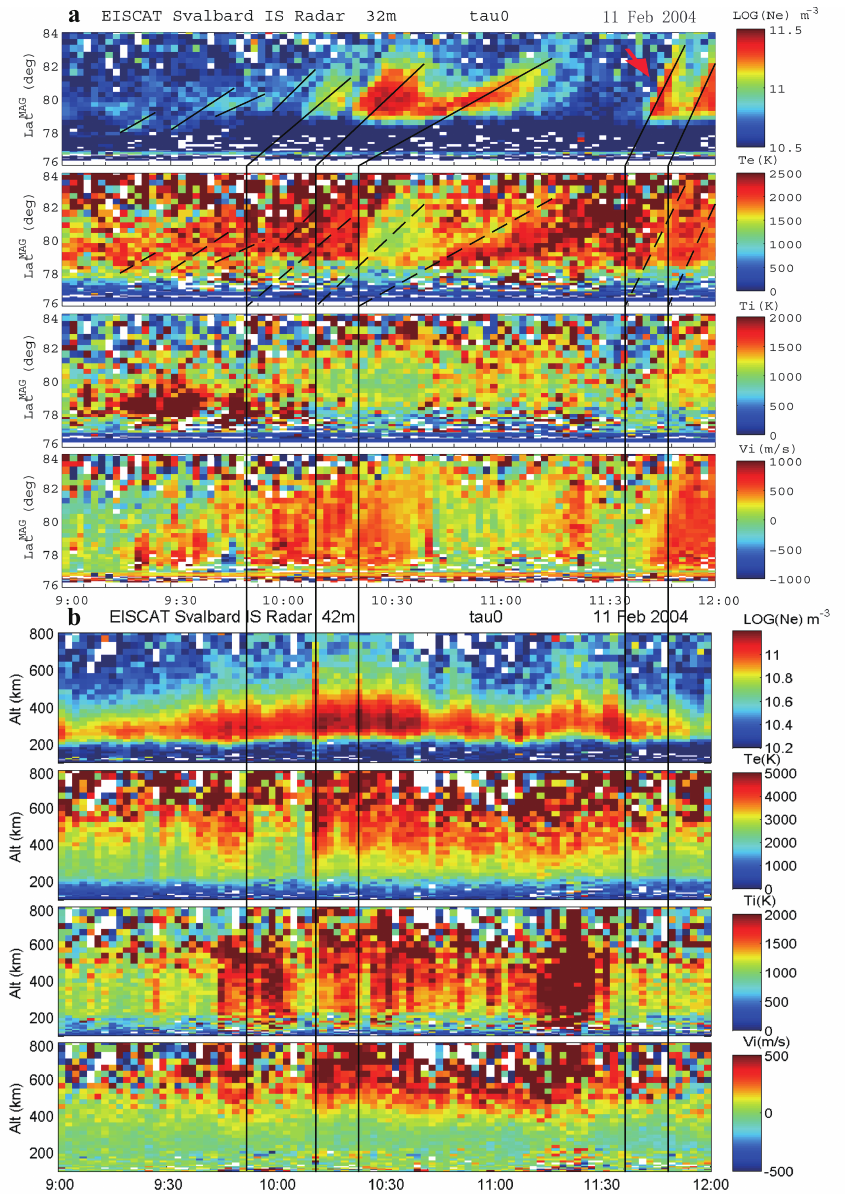
Fig. 7. Plasma parameters observed by the northward-directed ESR dish and the filed-aligned dish on 11 February 2004. From top to bottom: N e , electron density, T e , electron temperature, T i , ion temperature, and line of sight velocity, V i (positive away from the radar) as a function of time and magnetic latitude (shorten as “Lat MAG ” in a ) or altitude (shorten as “Alt” in b ).